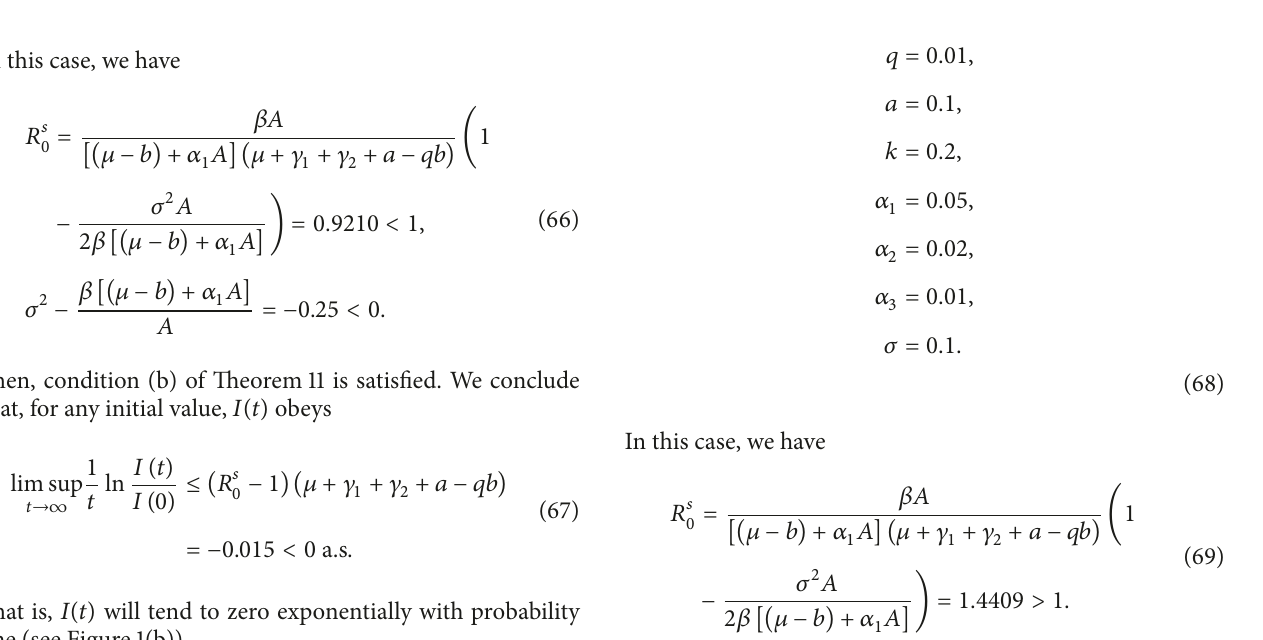
Figure 1: Computing simulation of the paths 𝐼(𝑡) for the SIRS epidemic model (6) and 𝐼(𝑡) of the corresponding deterministic system (4).